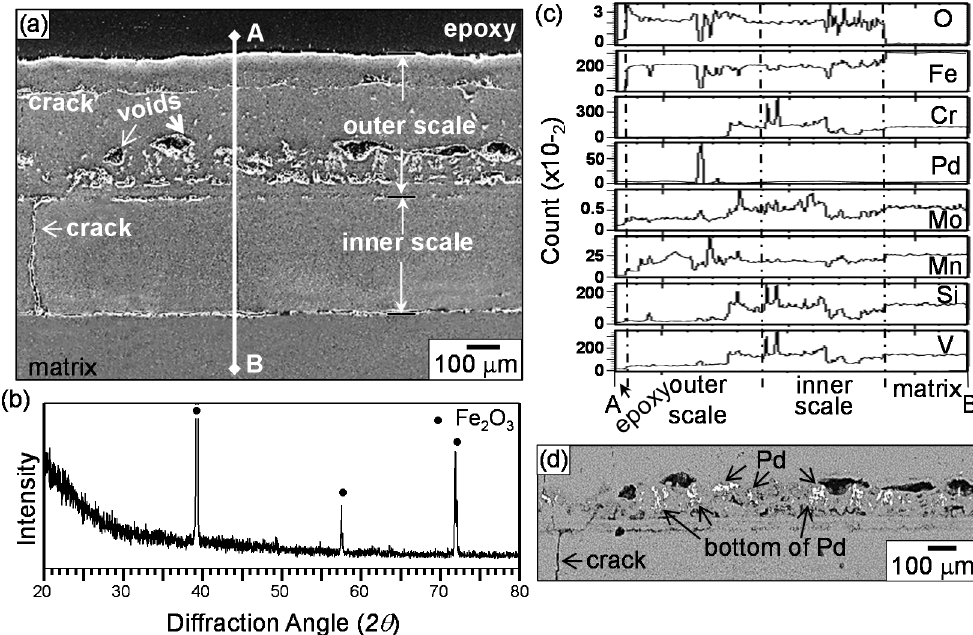
Figure 8. Uncoated P91 steel after oxidation at 900 °C for 20 h: ( a ) cross ‐ sectional EPMA image (unetched); ( b ) XRD pattern; ( c ) EPMA line profiles along A–B marked in (a); ( d ) enlarged SEM ‐ BSE image around the outer/inner oxide scale shown in (a).